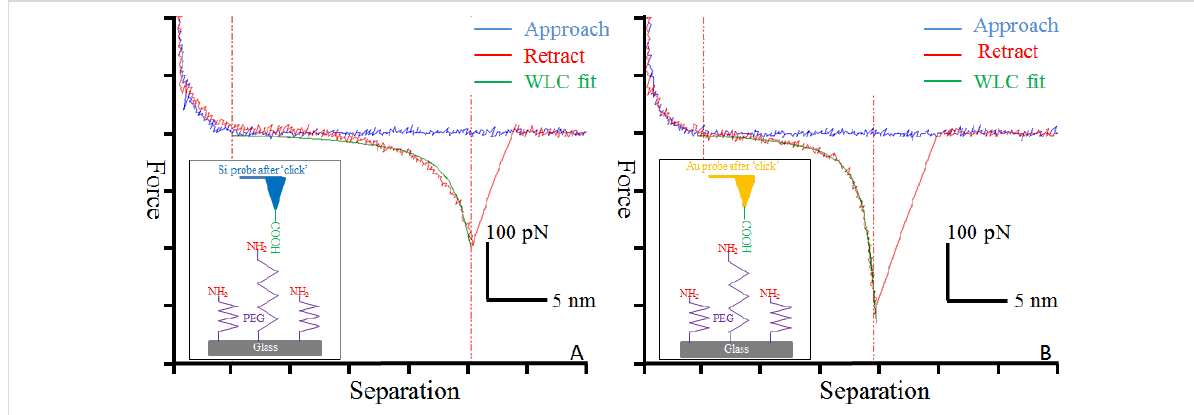
Figure 2: Typical force curves of modified single-molecule (A) Si probes and (B) Au-coated probes interacting with an amino-terminated PEG mono- layer on a glass slide. The approach (blue) and retract (red) curves along with worm-like chain model fitting curves (green) are shown, demonstrating the stretching behavior of a single PEG molecule between the probes and the